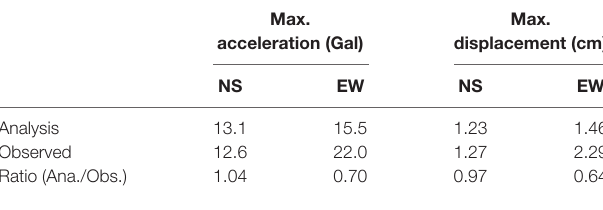
TaBle 5 | Maximum acceleration and displacement responses at 32F (3/9 pre-shock).